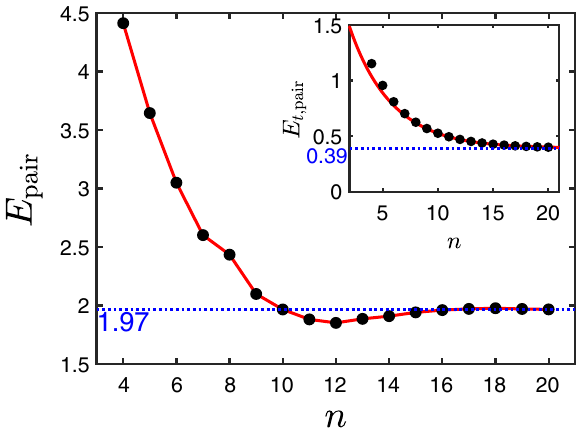
FIG. 8. The binding energy E n of a square subregion with the two holes confined inside which is embedded within a larger 24 × 24 lattice of the spin back- ground j ϕ 0 i as the half-filling ground state. Inset: the kinetic energy part of the binding energy, E exponential decay, saturating at a typical area of approximately 4 × 4 as indicated by the fitting curve (red) given by Eq.